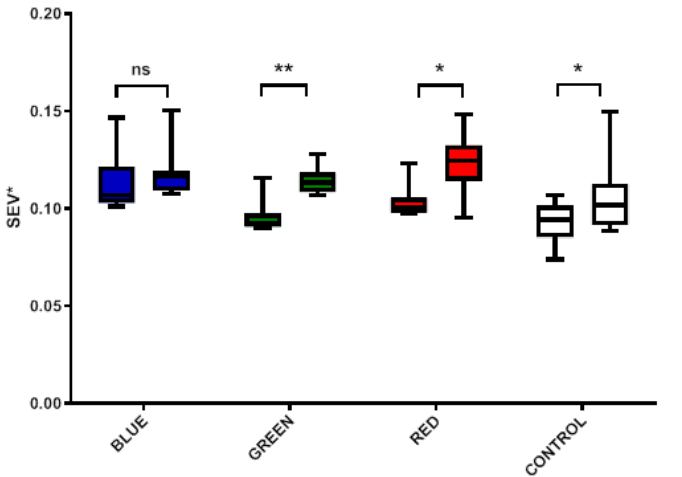
Figure 10. Mean standardized erythema value (SEV*) pre/post comparison per treatment group showing statistically significant increases in all groups except for blue. ns non-significant, * p < 0.05, ** p < 0.01 compared to the control group.